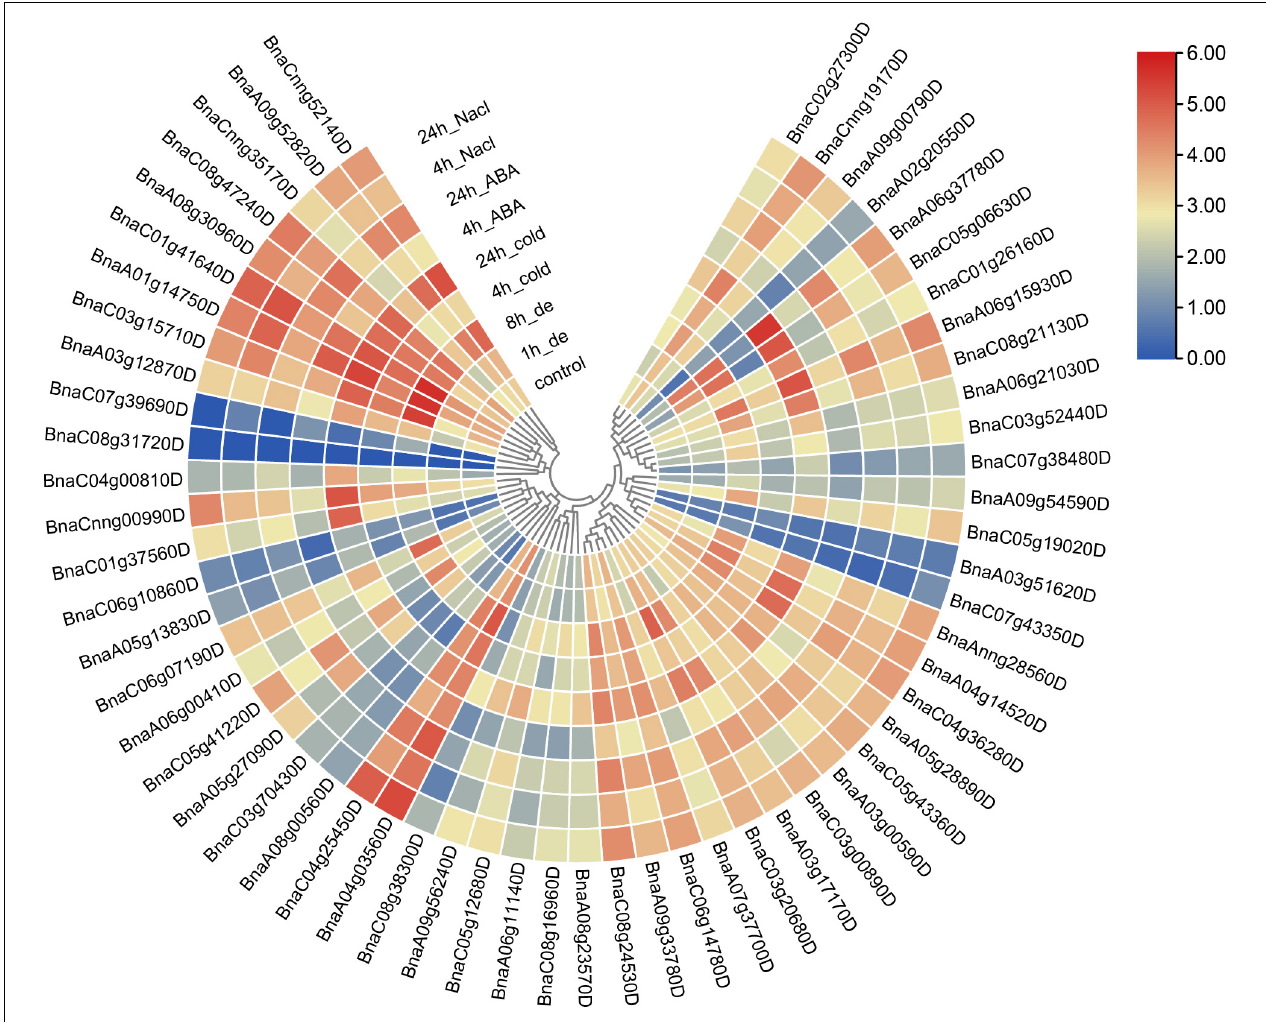
FIGURE 8 | Expression profiles of SR genes under abiotic stress conditions. Expression data were processed with log 2 normalization. The color scale represented relative expression levels from low (blue color) to high (red